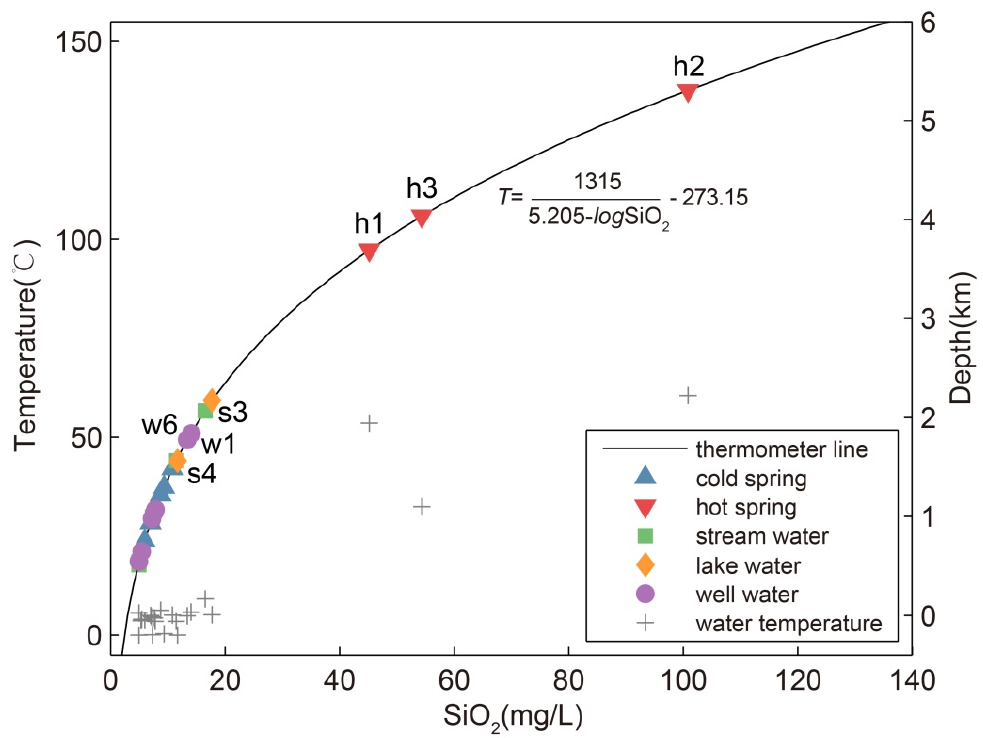
Figure 7. SiO 2 concentrations of 23 water samples and their estimated underground temperature and circulation depth.